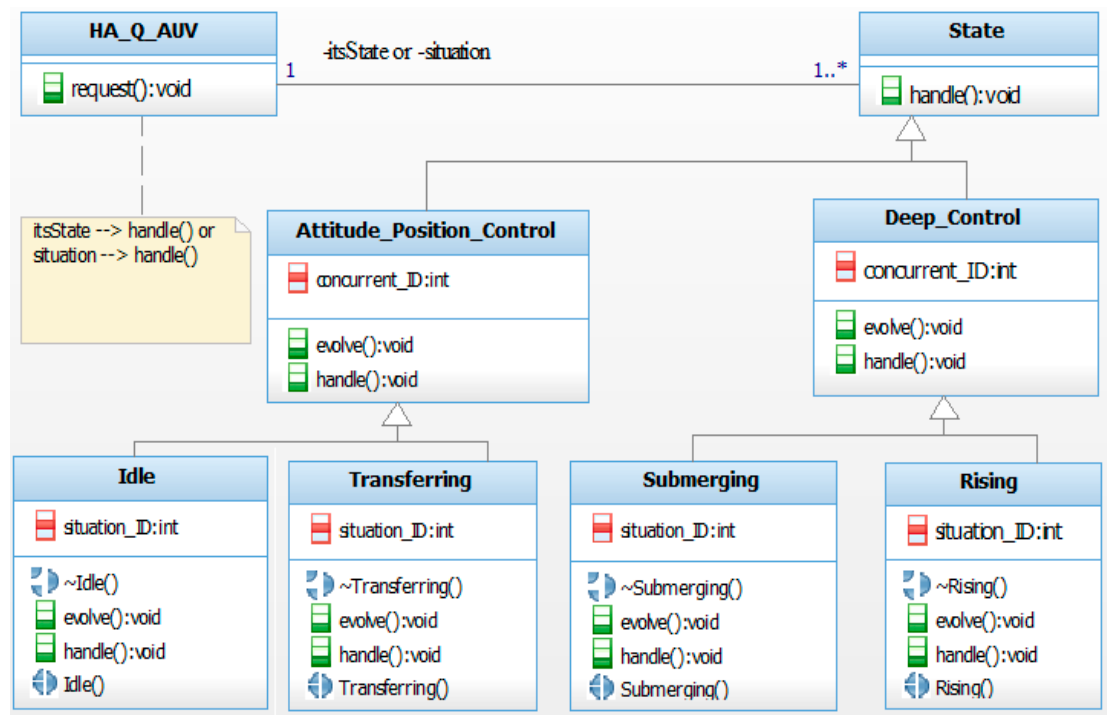
Figure 7. State pattern structure of hybrid automata (HA) for the AUV controller.